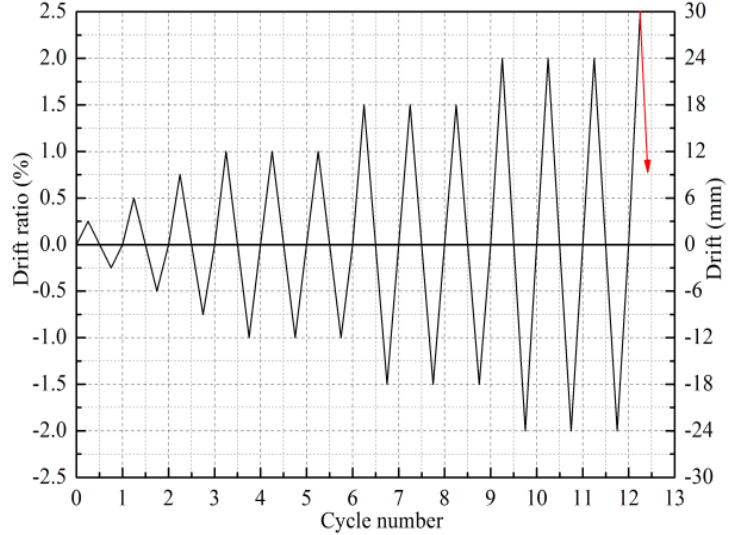
Figure 4. Loading spectrum.